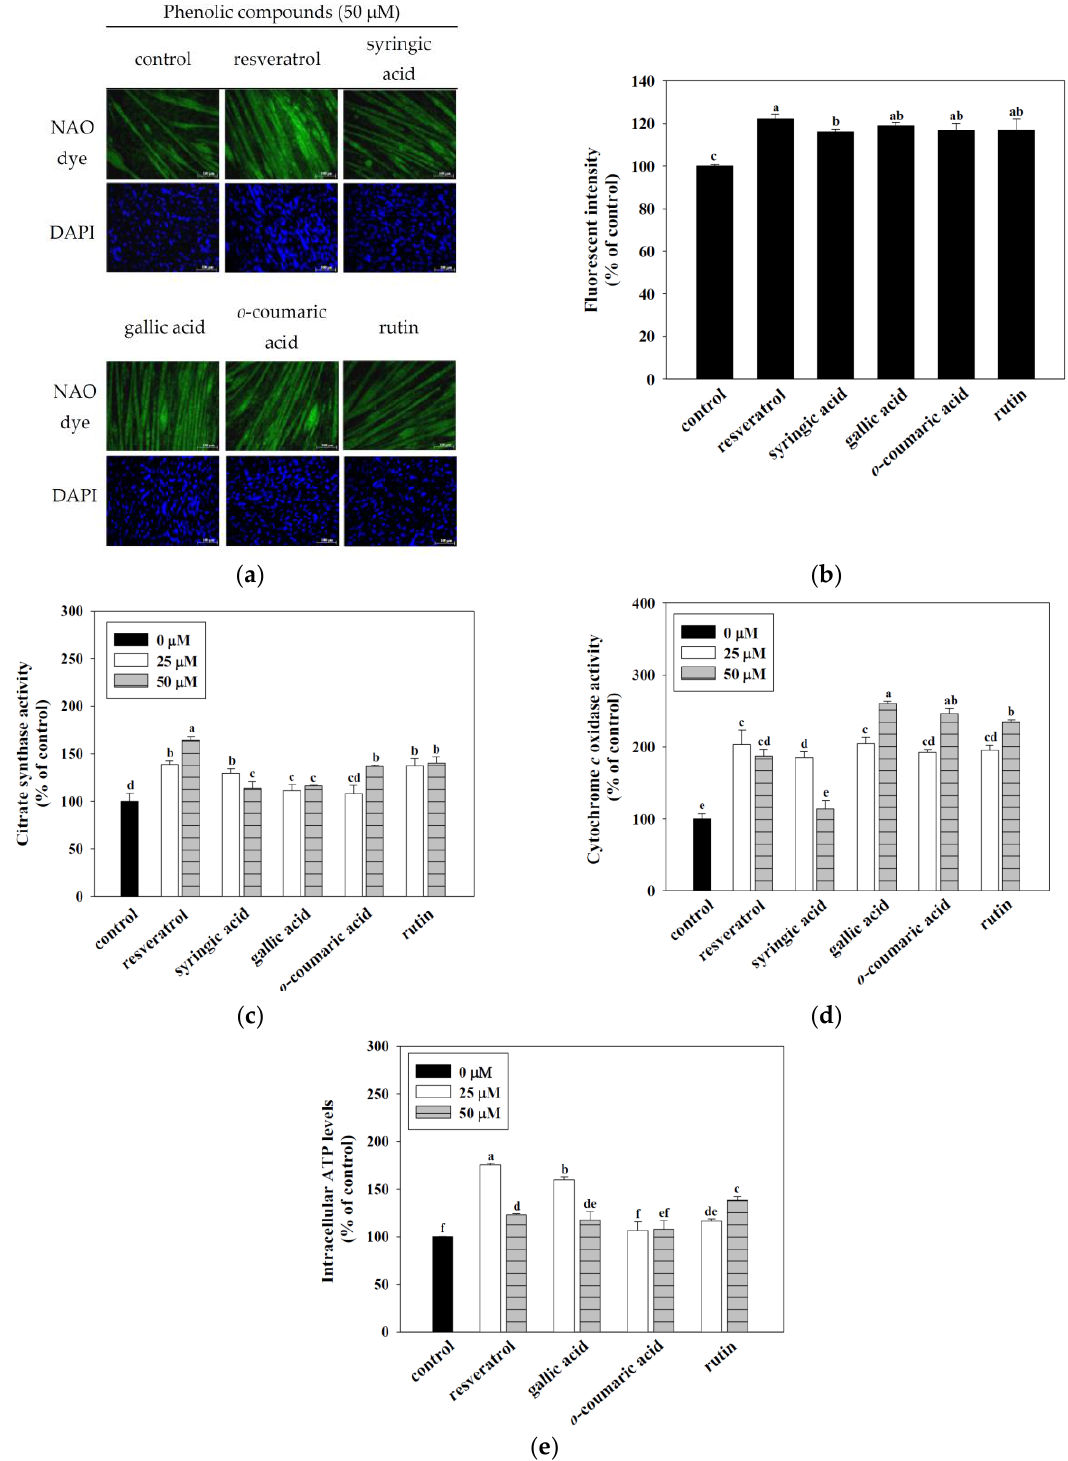
Figure 3 . Effects of resveratrol, syringic acid, gallic acid, o -coumaric acid, and rutin on mitochondrial content ( a , b ) mitochondrial enzyme activities ( c , d ), and intracellular ATP levels ( e ) in C2C12 myotubes. C2C12 myotubes were incubated with 50 µ M resveratrol, syringic acid, gallic acid, o -coumaric acid, and rutin for 24 h at 37 ◦ C in a humidified 5% CO 2 incubator. Representative NAO dye and DAPI staining of the C2C12 myotubes are shown at 200 × magnification. For intracellular ATP levels, C2C12 myotubes were incubated with 25 and 50 µ M of resveratrol, gallic acid, o -coumaric acid, and rutin for 24 h at 37 ◦ C in 5% CO 2 incubator. ATP concentrations were normalized to control. The enzyme activities of citrate synthase and cytochrome c oxidase are expressed as a percentage, with the value of control set at 100%. The reported values are the means SD ( n = 3). Mean values with different letters were significantly different ( p < 0.05).